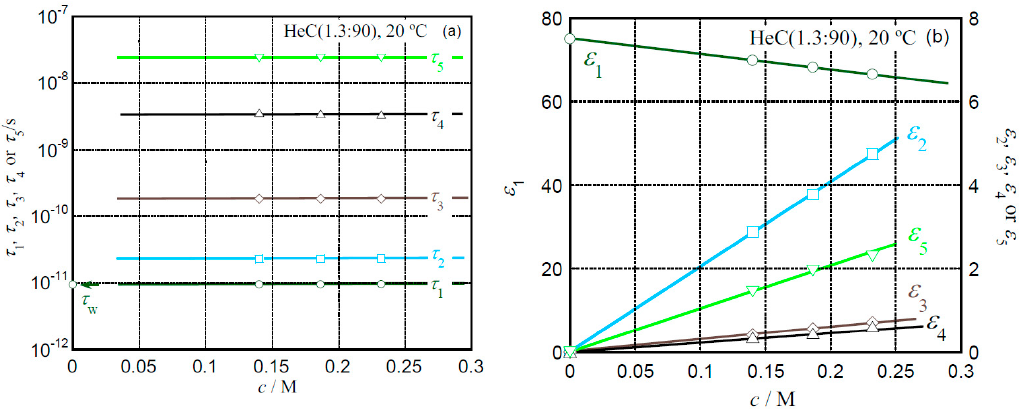
Figure 2. Concentration dependence of dielectric relaxation times ( a ) and strength ( b ) for each mode observed in aqueous solution of HeC(1.3:90) at T = 20 °C shown in Figure 1a.